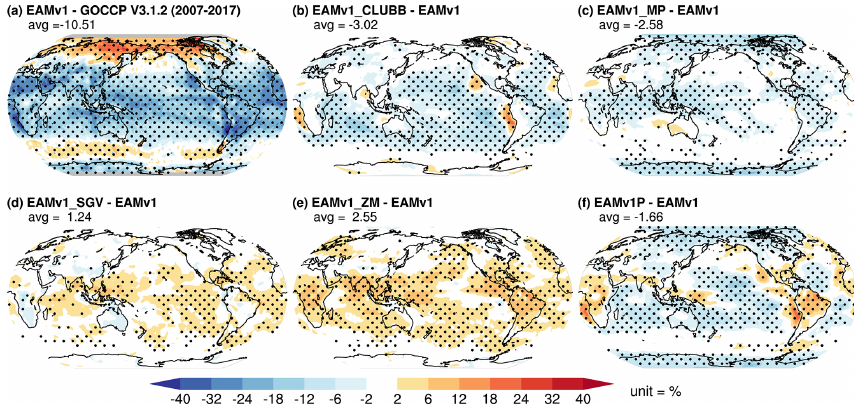
Figure 5. Total cloud fraction between (a) EAMv1 and the version 3.1.2 of the GOCCP total cloud fraction (Chepfer et al., 2010) averaged over 2007–2017, (b) EAMv1_CLUBB and EAMv1, (c) EAMv1_MP and EAMv1, (d) EAMv1_SGV and EAMv1, (e) EAMv1_ZM and EAMv1, and (f) EAMv1P and EAMv1. Model cloud fractions are derived from the CALIPSO cloud simulator (Chepfer et al., 2008) sampled at